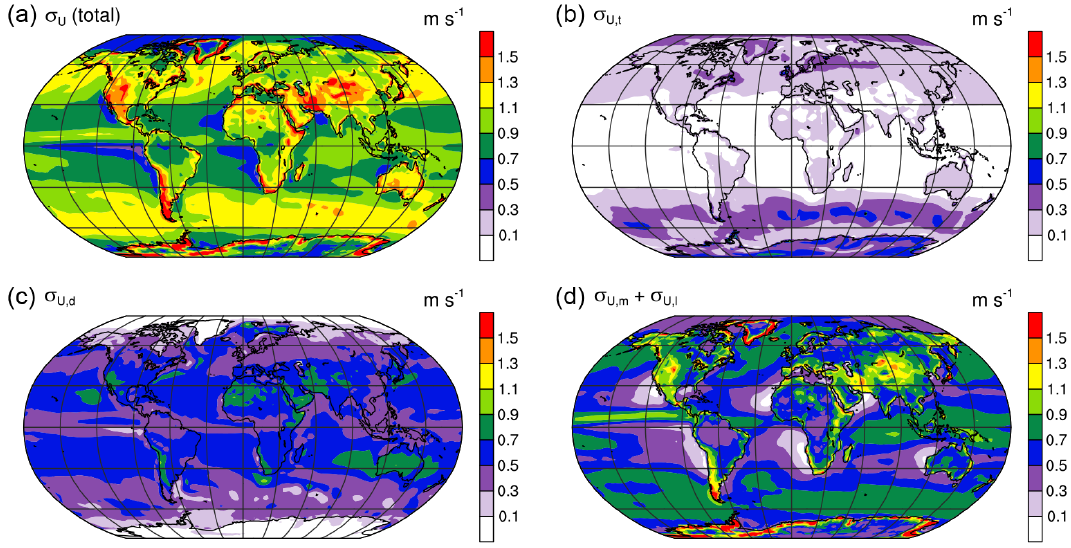
Figure 14. Annual mean sub-grid standard deviation of surface wind speed in CAM5: (a) total (Eq. 19), (b) neutral/stable turbulent mixing (Eq. 20), (c) dry convective eddies (Eq. 21), (d) moist convective eddies over the ocean (Eqs. 23–24) and mesoscale flow over land (Eq. 27). Table 1. List of CAM5 simulations discussed in Sect. 5. DU and SS refer to dust and sea salt emissions, respectively. “With PDF” means the Weibull distribution of wind speed is used in the emission calculations (cf. Sect. 2.5). “Without PDF” means the enhancement of grid-box mean wind speed is taken into account, but the emission calculations use only the (enhanced) mean wind speed, not the Weibull PDF. Simulation Source of sub-grid wind variability Dust Turbulence Dry convective eddy Moist convective eddy Mesoscale flows over topography Emission (Eq. 20) (Eq. 21) (ocean; Eqs. 23 and 24) (land; Eqs. 26 and 27)